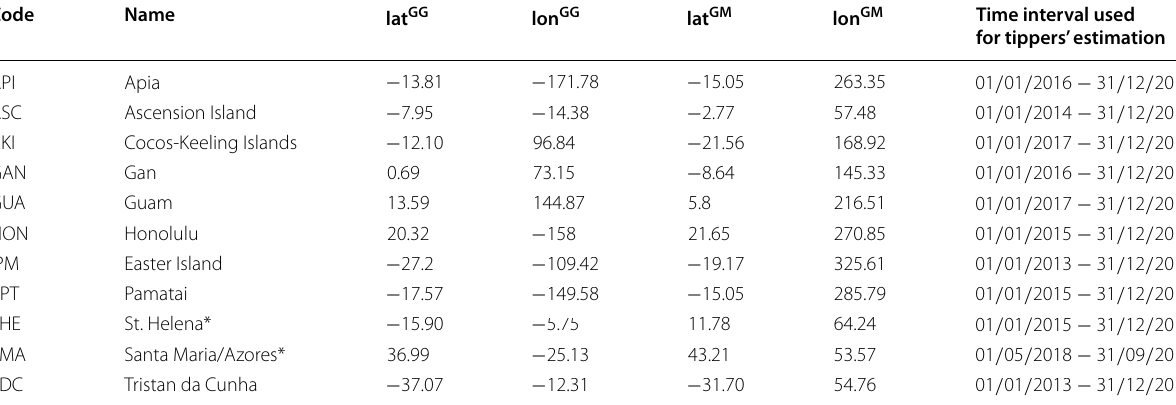
From left to right: IAGA code, observatory name, geographic and geomagnetic latitude and longitude, and time interval used to estimate tippers. Observatories with an asterisk (*) are, as of date, not participating in INTERMAGNET and data are available from GFZ Potsdam. Geomagnetic coordinates were calculated using the IGRF- 12 model, epoch